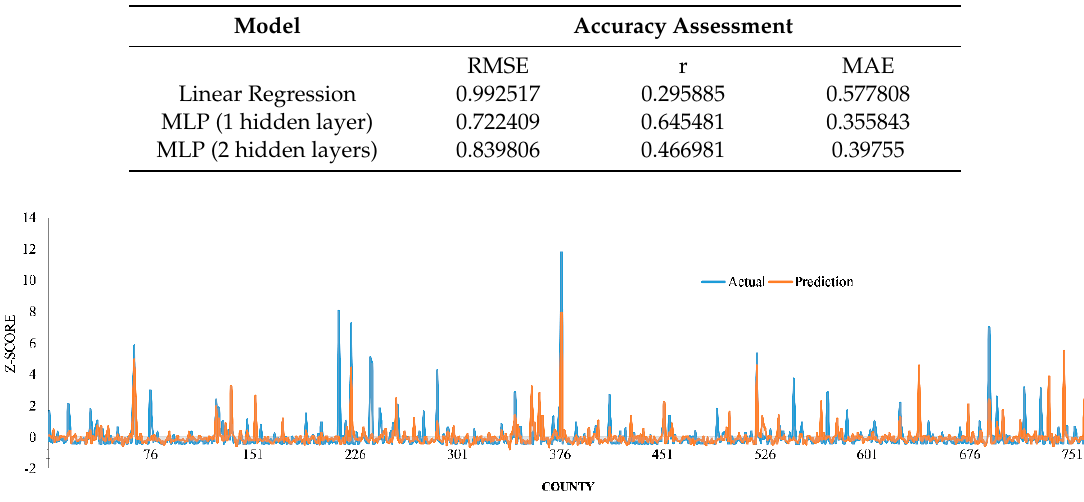
Figure 3. Comparison of actual and predicted values of the dependent variable (z-scores) for holdout samples using the one-hidden-layer MLP. Table 1. Comparative performance of the employed models (single run) to predict COVID-19 rates across the continental United States.